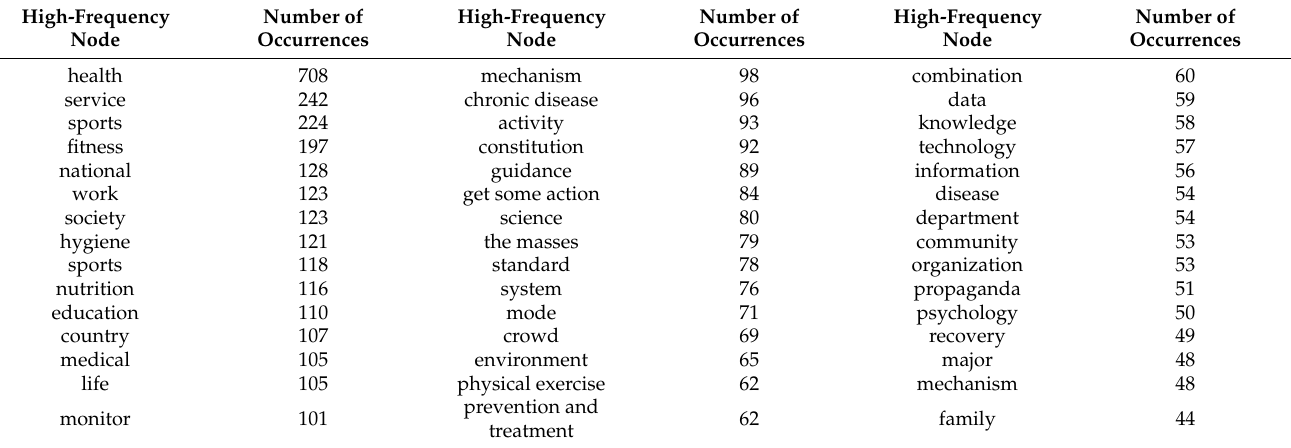
Table 2. Word frequency analysis results of related nodes with respect to the integration of sports and